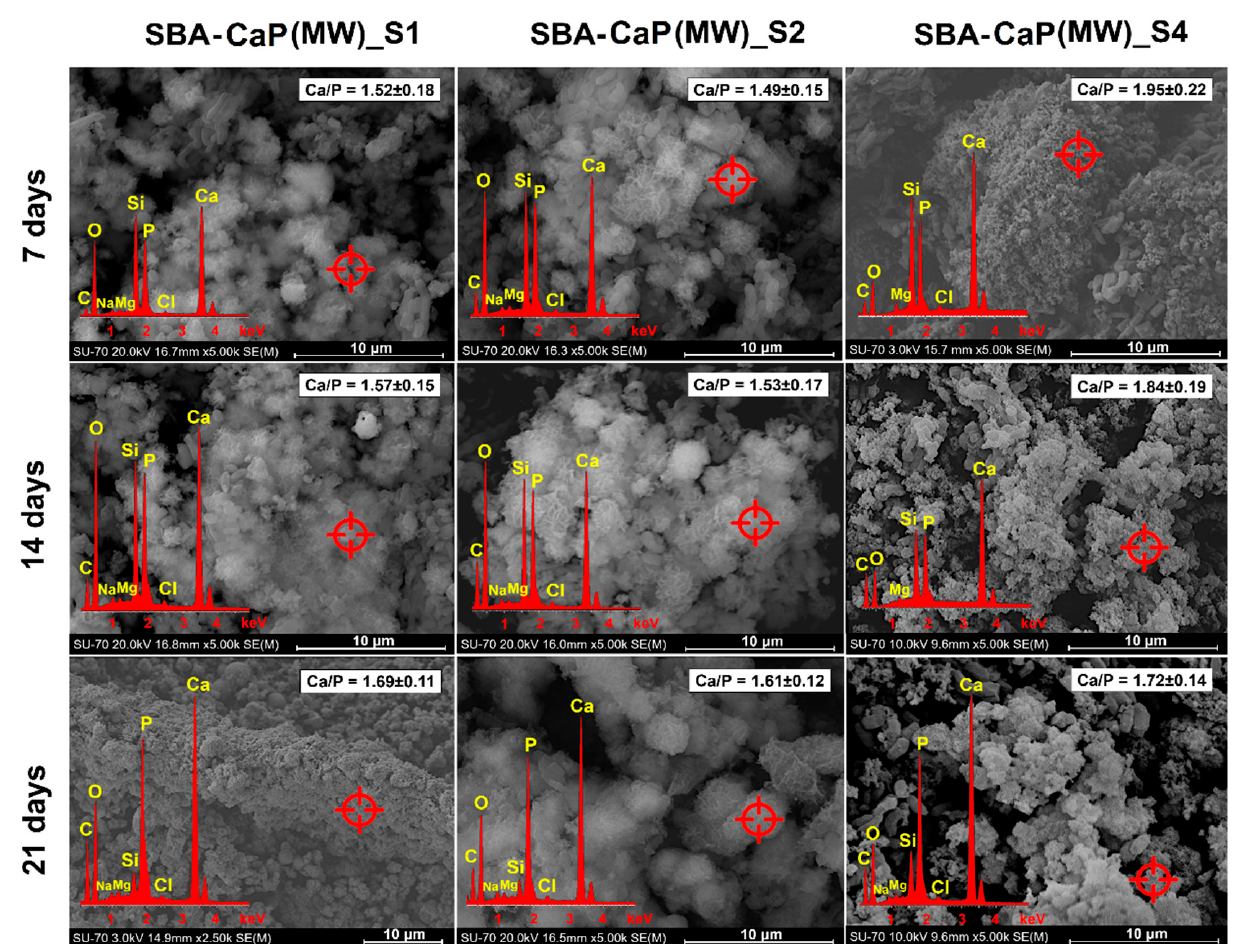
Figure 2. SEM-EDX micrographs of selected SBA-CaP(MW) composites after 7 days, 14 days, and 21 days of immersion in simulated body fluid.